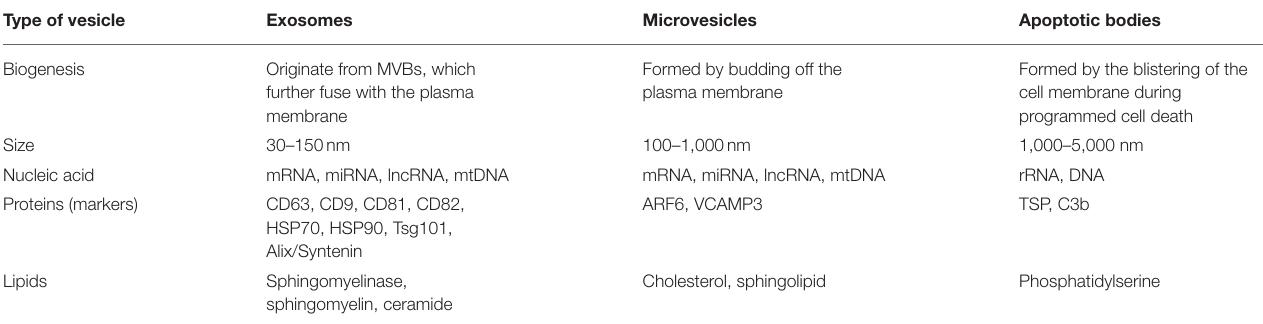
TABLE 1 | Classification of extracellular vesicles